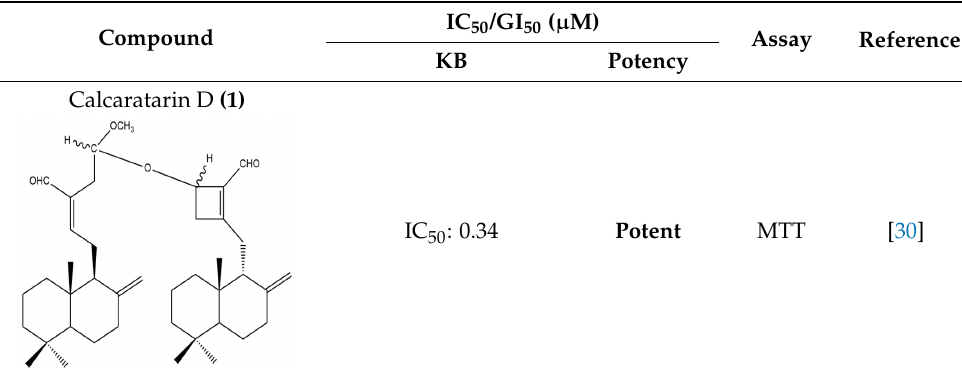
Table 7. Cytotoxic activities of labdane-type diterpenes from the Zingiberaceae against KB cervical cancer cell line.